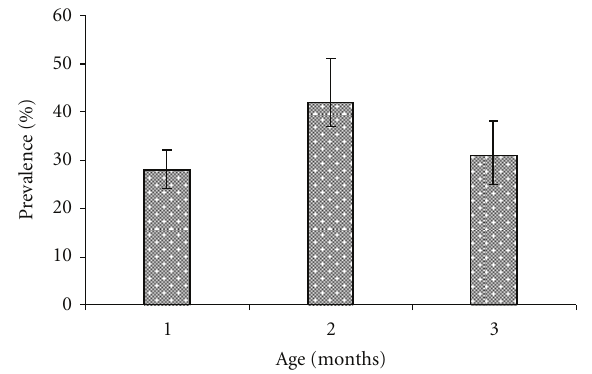
Figure 1: Age prevalence profile ( ± 95%CI) of Cryptosporidium oocysts in the sampled calves in Tanga (May 2003–January 2004).